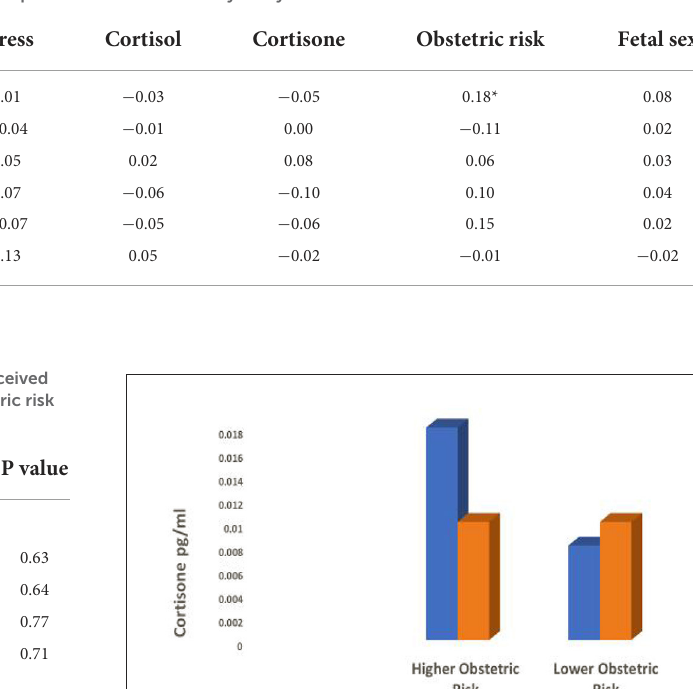
TABLE 2 Pearson correlation coefficients for the relationship of potential covariates to key study variables.